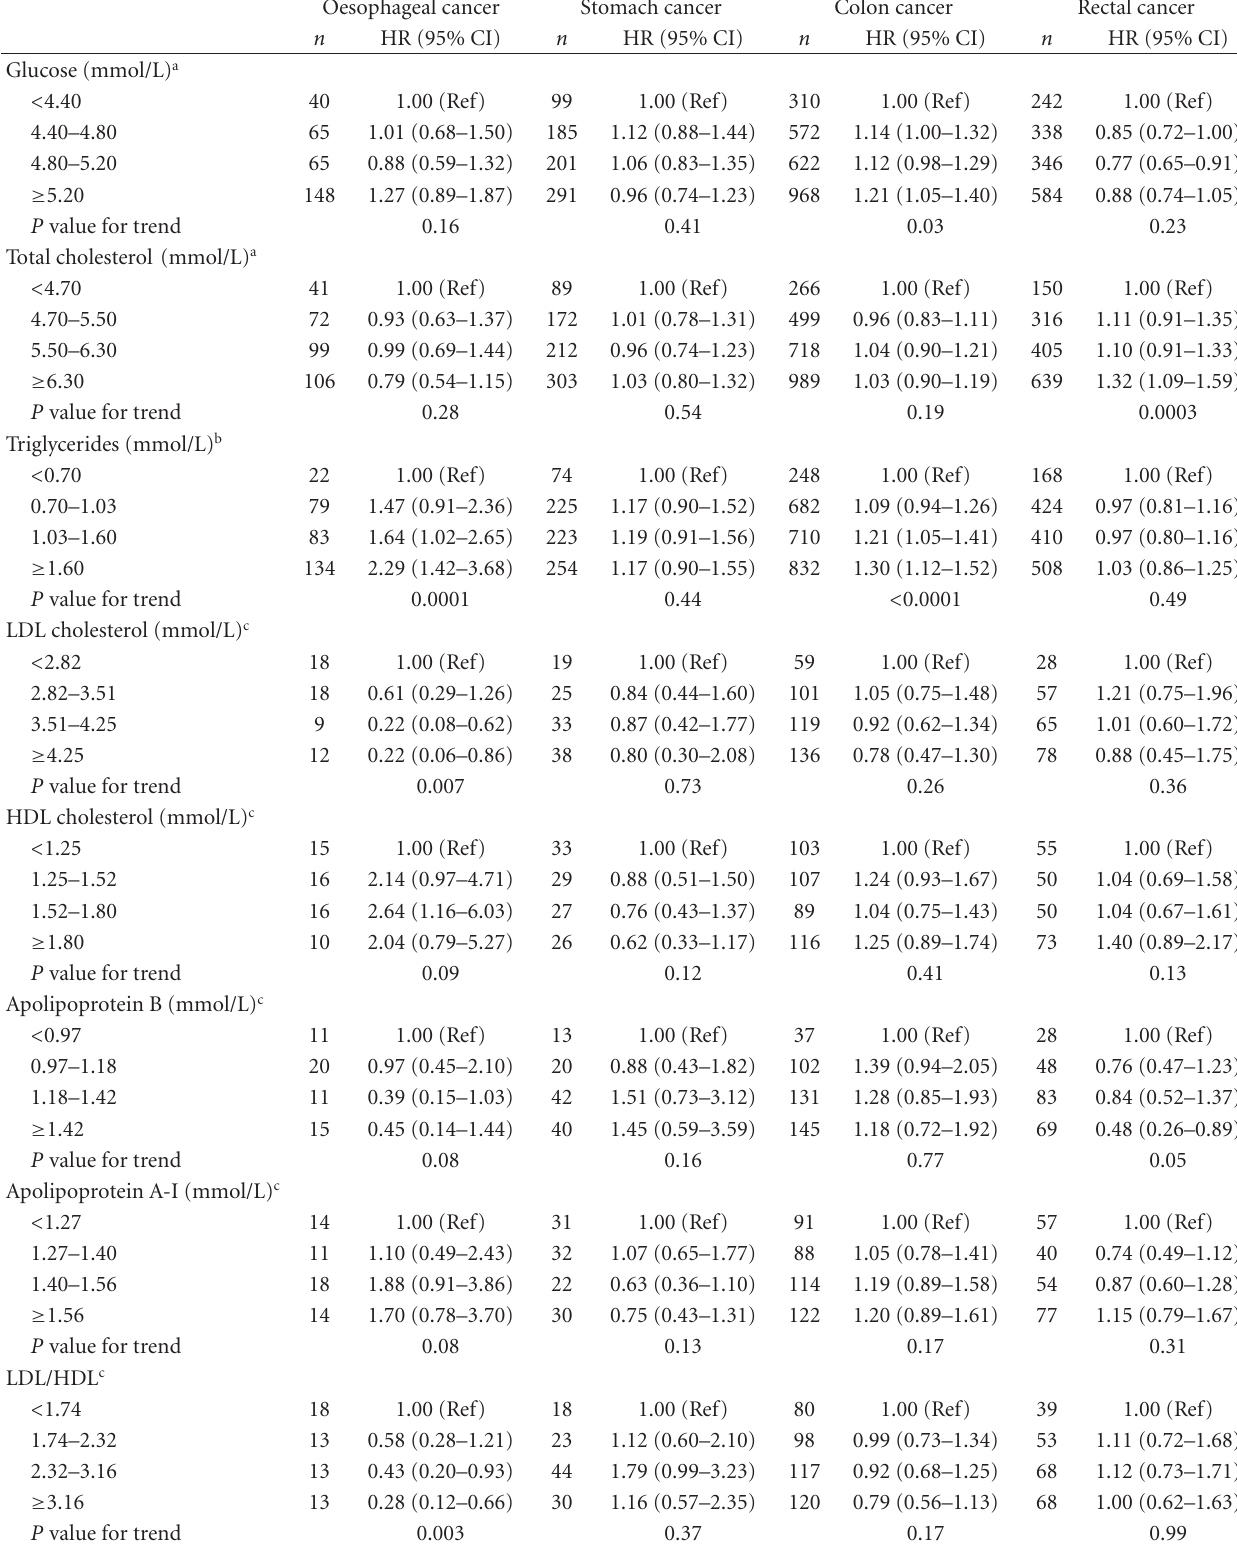
Table 2: Hazard ratios and 95% confidence intervals for GI cancer for quartiles of lipid components, adjusted for age, gender, SES, fasting status, glucose (continuous), total cholesterol (continuous), and triglycerides